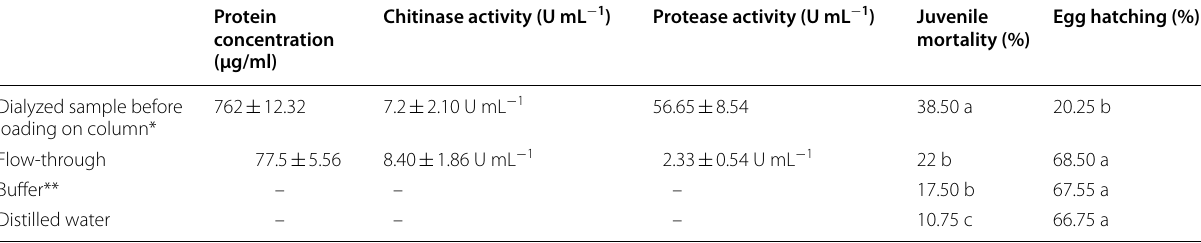
Values followed by the same letter are not significantly different at 1%, as determined by analysis of variance followed by Fisher’s test. This experiment was conducted twice with the same results * Protein sample was prepared by acetone precipitation of secretory proteins from medium culture of AzBw1 and dialyzed against 20 mM Tris buffer ** 500 mM NaCl in 20 mM Tris buffer (pH